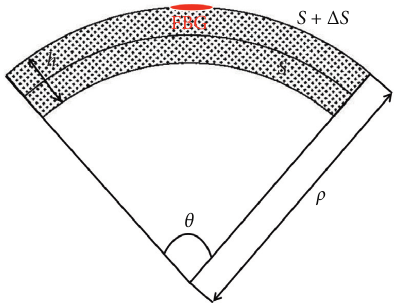
Figure 1: Principle of smart geogrid curvature